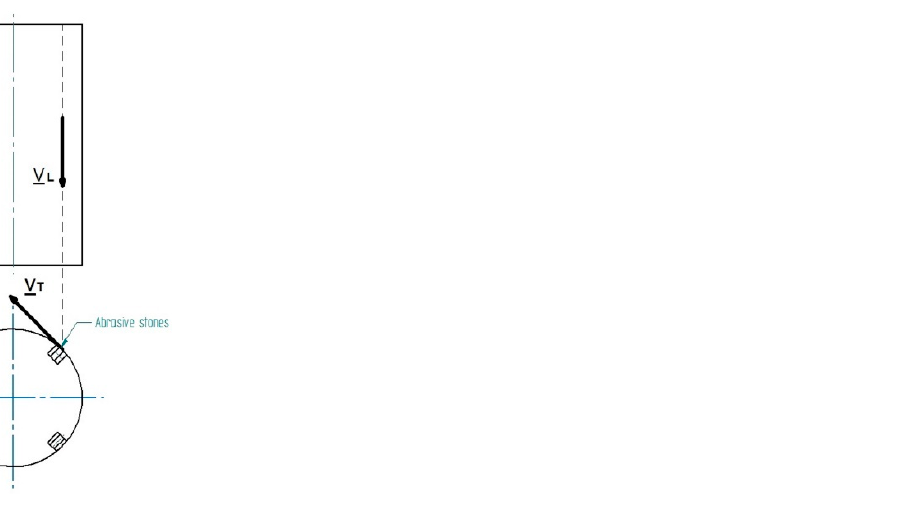
Figure 1. Schematic of the honing process: VL is linear speed of the honing head, VT is tangential speed (corresponding to the rotation speed n of the cylinder). In this example, the honing head is provided with 4 abrasive stones.